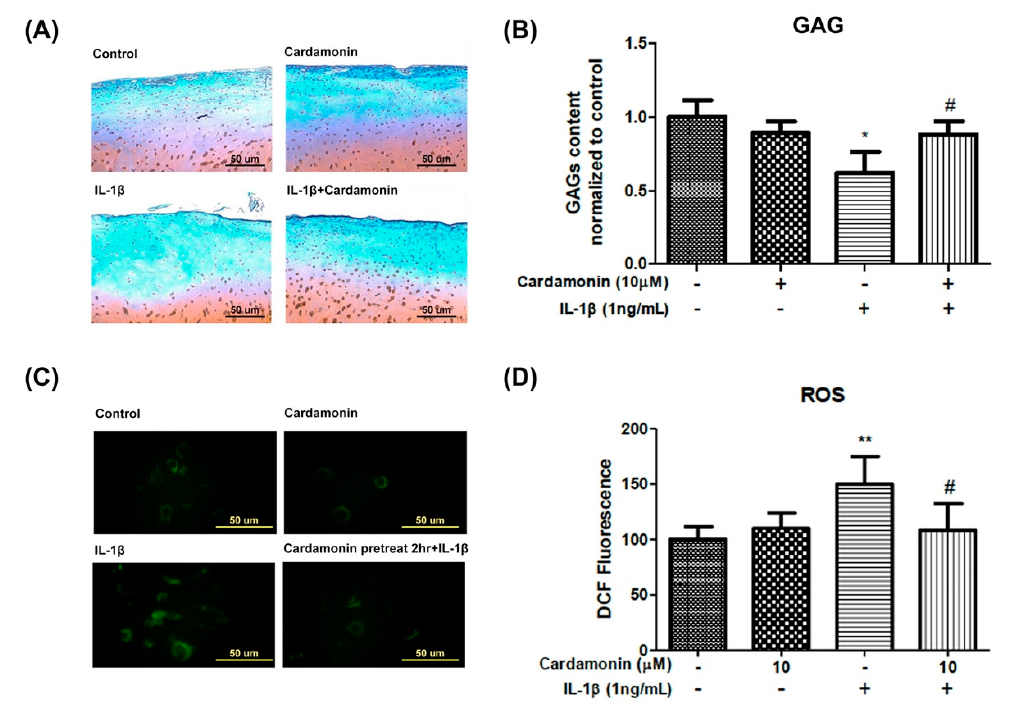
Figure 3. Effects of cardamonin on IL-1 β -induced cartilage defects and ROS generation in human OA chondrocytes. ( A , B ) Cardamonin significantly decreased IL-1 β -induced cartilage defects in chondrocytes. ( C , D ) Cardamonin suppressed IL-1 β -stimulated generation of ROS in chondrocytes. Following pretreatment with cardamonin for 2 h, cells were stimulated using IL-1 β . A fluorescence microscope and Image J software were used to assess ROS fluorescence intensity and perform quantitative analysis. All data comes from at least three independent experiments, and their significance were as follows: cardamonin group and the control group are indicated by an asterisk (*); cardamonin group and the IL-1 β group are indicated by a hash symbol (#). *, # p < 0.05; ** p < 0.01.